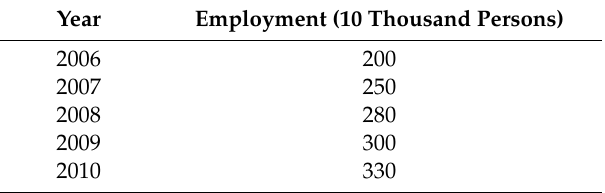
Table 4. Employment in the solar water heater industry between 2006 and